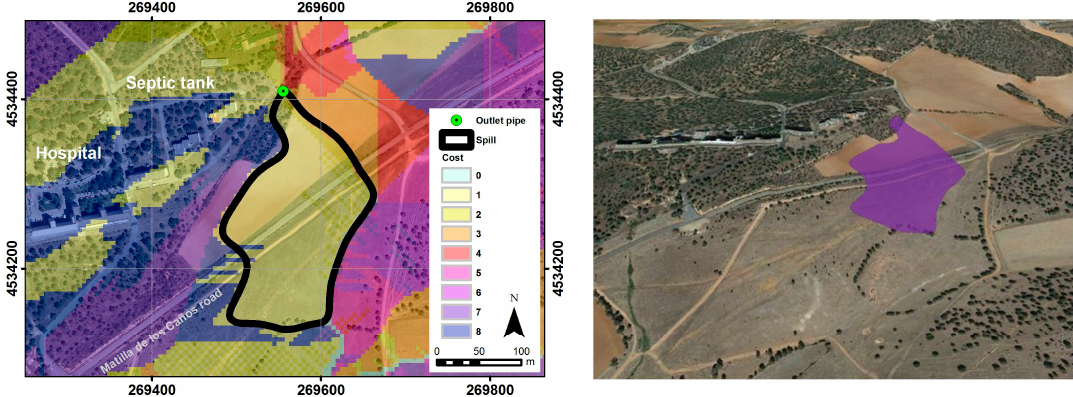
Figure 6. Delimitation of effluent discharge using GIS techniques based on a cost–distance algorithm ( left ) and 3D (three dimensional) modeling with an ArcScene script ( right ).